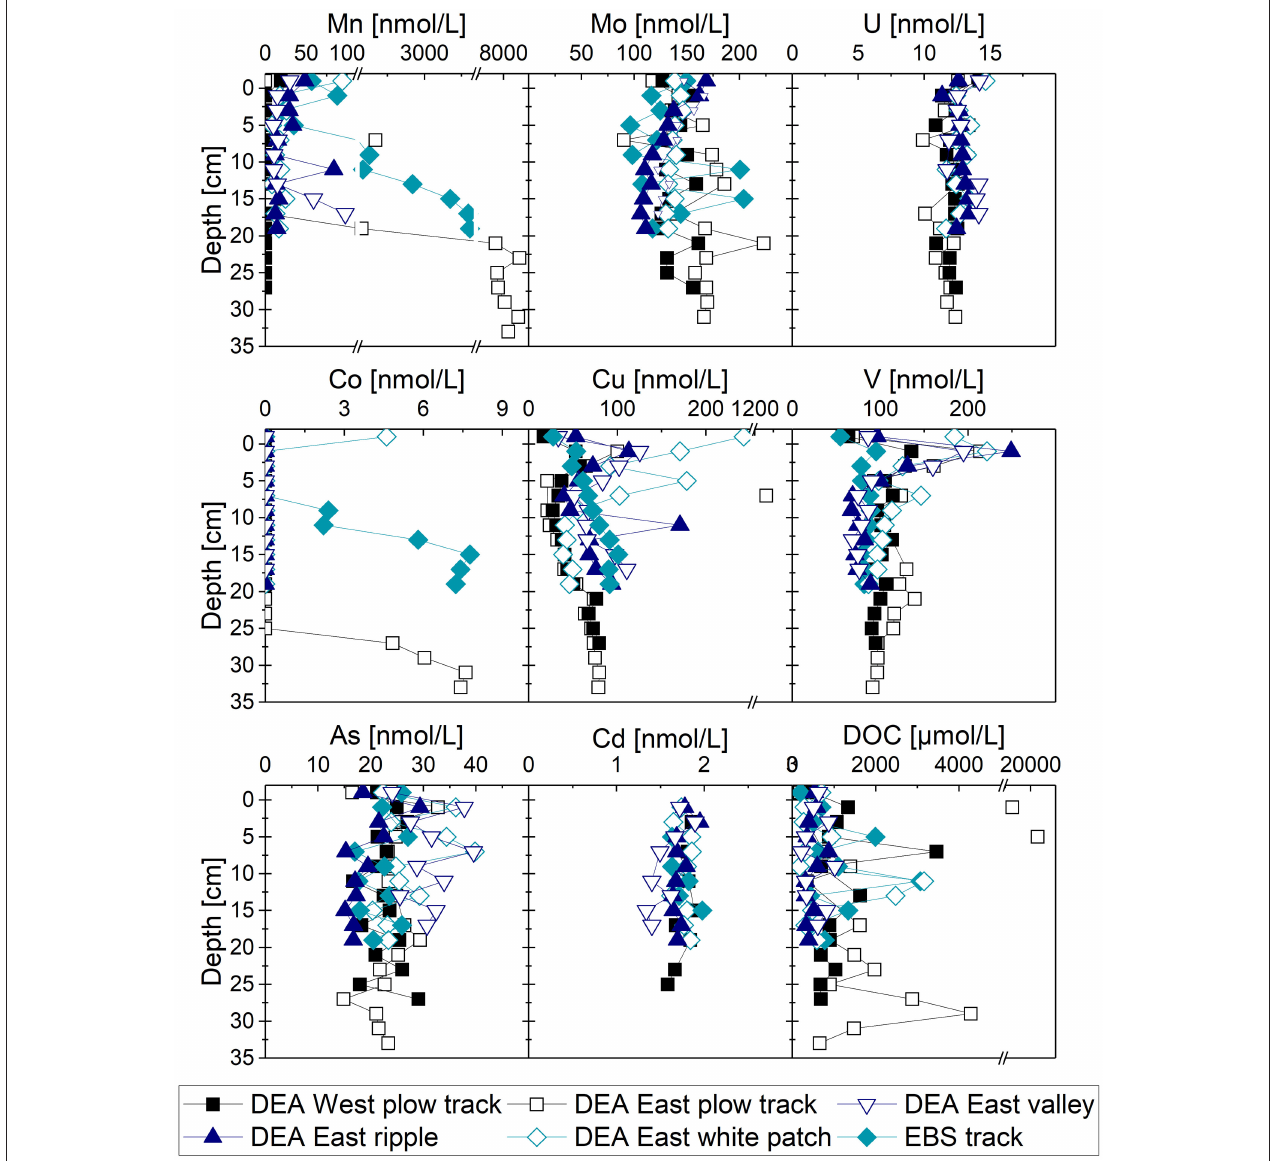
FIGURE 8 | Bottom and pore water element profiles of five 26-year old disturbed sites and the 5-week old EBS track. The uppermost values refer to bottom water concentrations measured in the supernatant retrieved above the sediment surface in the MUC liner. Mn and Co below the LOQ for DEA West plow track.